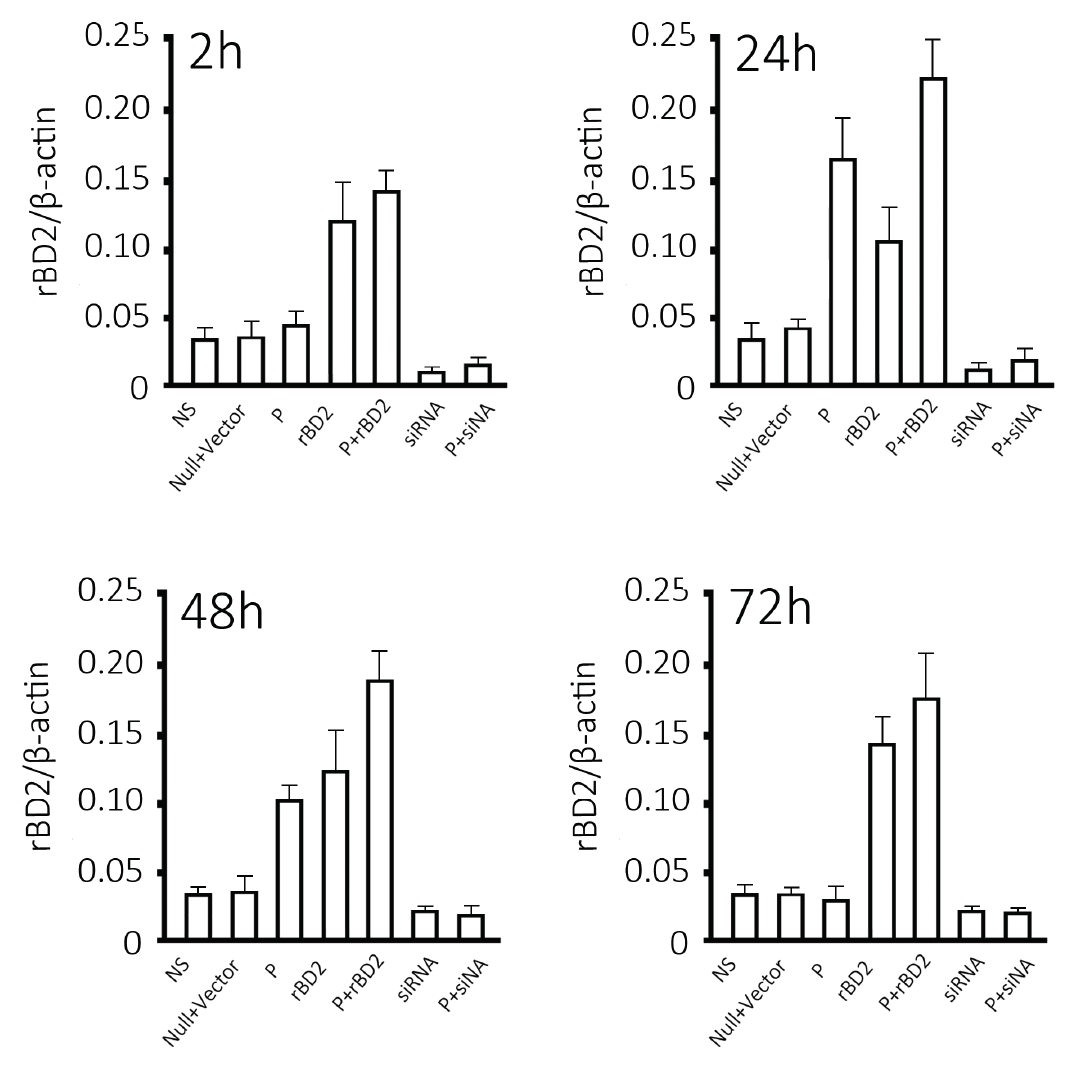
Figure 1. Overexpression and knockdown of rBD2 mRNA and protein. ( A ) Relative rBD2 mRNA levels normalized by β -actin at indicated time points. Data were expressed as mean ± SD. Groups: normal saline group (NS), group treated with null lentivirus (null vector), Pseudomonas aeruginosa infected group (P), group treated with rBD2 expression lentivirus ( rBD2 ), Pseudomonas aeruginosa infected group pretreated with rBD2 expression lentivirus (P + rBD2 ), group pretreated with rBD2 shRNA lentivirus (shRNA) and Pseudomonas aeruginosa infected group pretreated with rBD2 shRNA lentivirus (P + shRNA); ( B ) Representative western blots of rBD2 at indicated time points. GAPDH serves as an internal loading reference. Lanes: normal saline group (1); group treated with null lentivirus (2); Pseudomonas aeruginosa infected group (3); group treated with rBD2 expression lentivirus (4); Pseudomonas aeruginosa infected group pretreated with rBD2 expression lentivirus (5); group pretreated with rBD2 shRNA lentivirus (6) and Pseudomonas aeruginosa infected group pretreated with rBD2 shRNA lentivirus